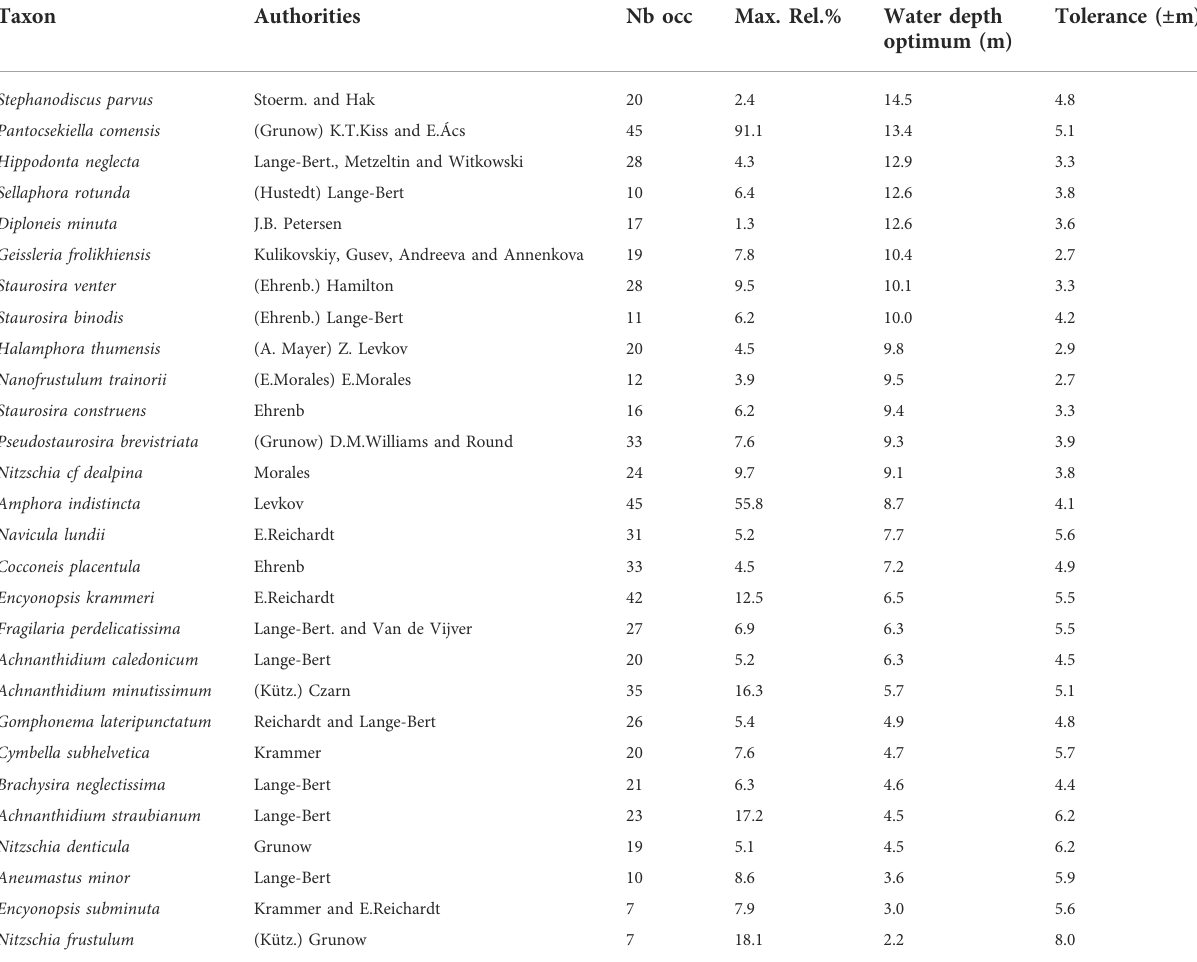
TABLE 1 Water depth optima and tolerance obtained from the WA-PLS model for the main species found in the surface sediment samples of Lake Kalakuli. Taxa are listed according to their water depth optima, in decreasing order.